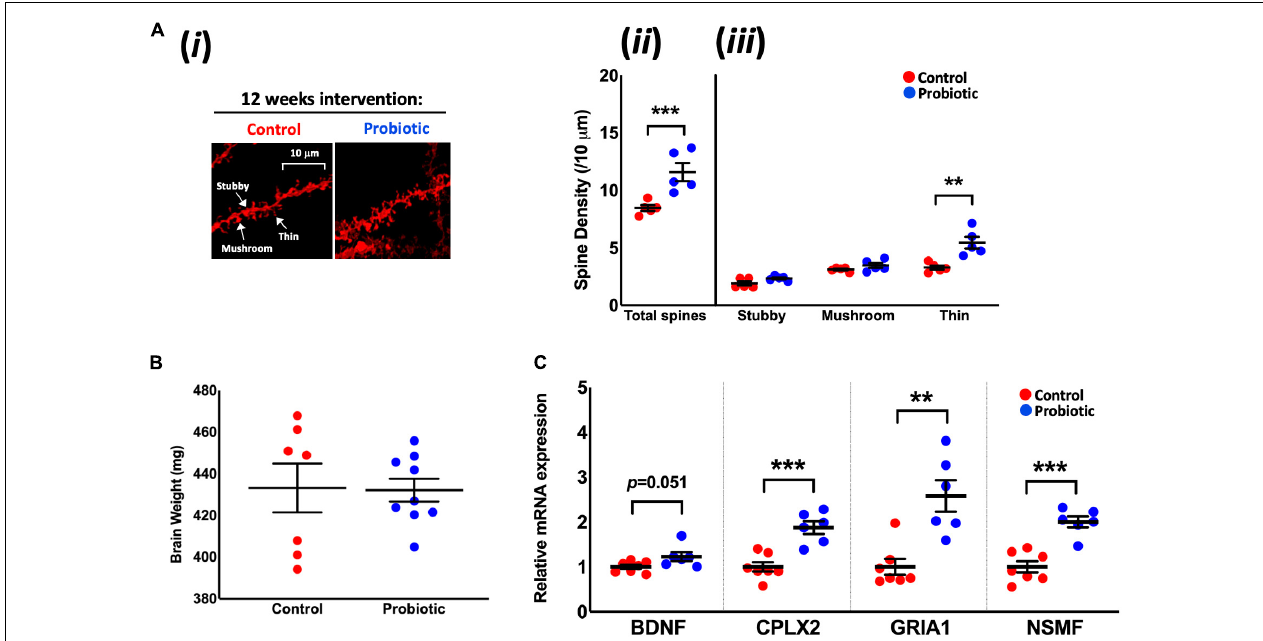
FIGURE 2 | Neuronal spine density and the mRNA levels of cognition-related genes in the brain. (Ai) Representative DiOlistic images showing thin, stubby, and mushroom dendrites in the CA1 hippocampus region of the Control and Probiotic groups and comparisons in the density of (Aii) total and (Aiii) stubby, mushroom, and thin spines. (B) Average brain weights. (C) Relative mRNA expression levels of BDNF, CPLX2, GRIA1, and NSMF in whole brain extracts of 3xTg-AD mice. Data are expressed as mean ± SEM of five mice per group (A) or at least six per group (B,C) . Values of p were determined using one-way ANOVA with Holm–Sidak or using an unpaired t -test. ** p < 0.01, *** p < 0.001 or as stated. BDNF, Brain-derived neurotrophic factor; CPLX2, Complexin-2; GRIA1, Glutamate Receptor Ionotropic AMPA Type Subunit 1; NSMF, neuronal migration